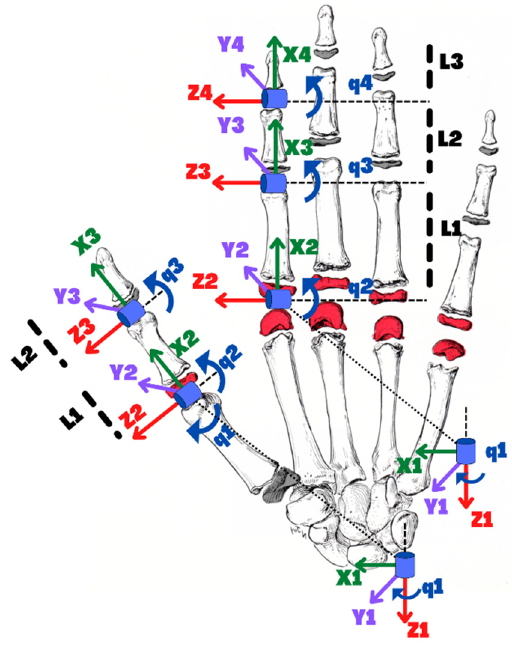
Figure 3. Reference Hand for Modified DH parameters. Table 1. Modified DH parameters for all fingers, excluding the thumb.